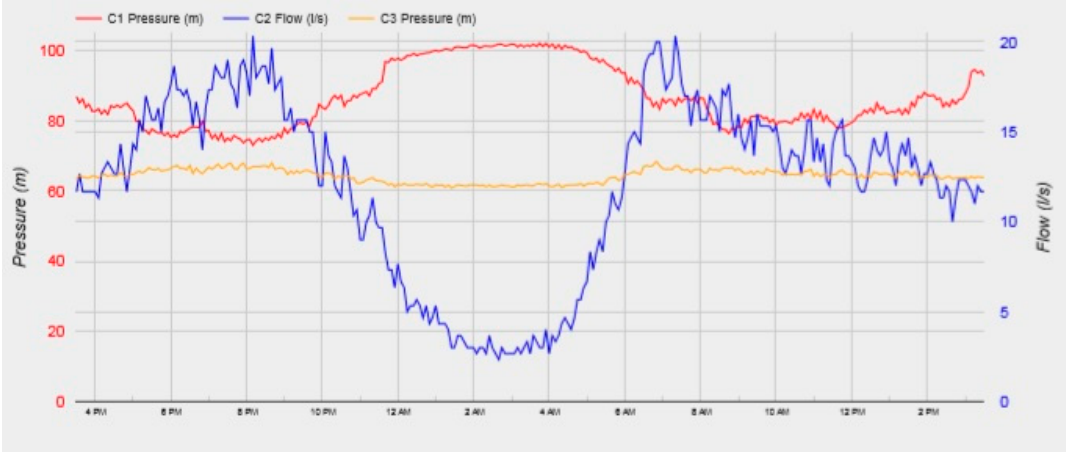
Figure 4. 24-h (15 min) diagram at the DMA’s PRV site from the 5th to the 6th of June